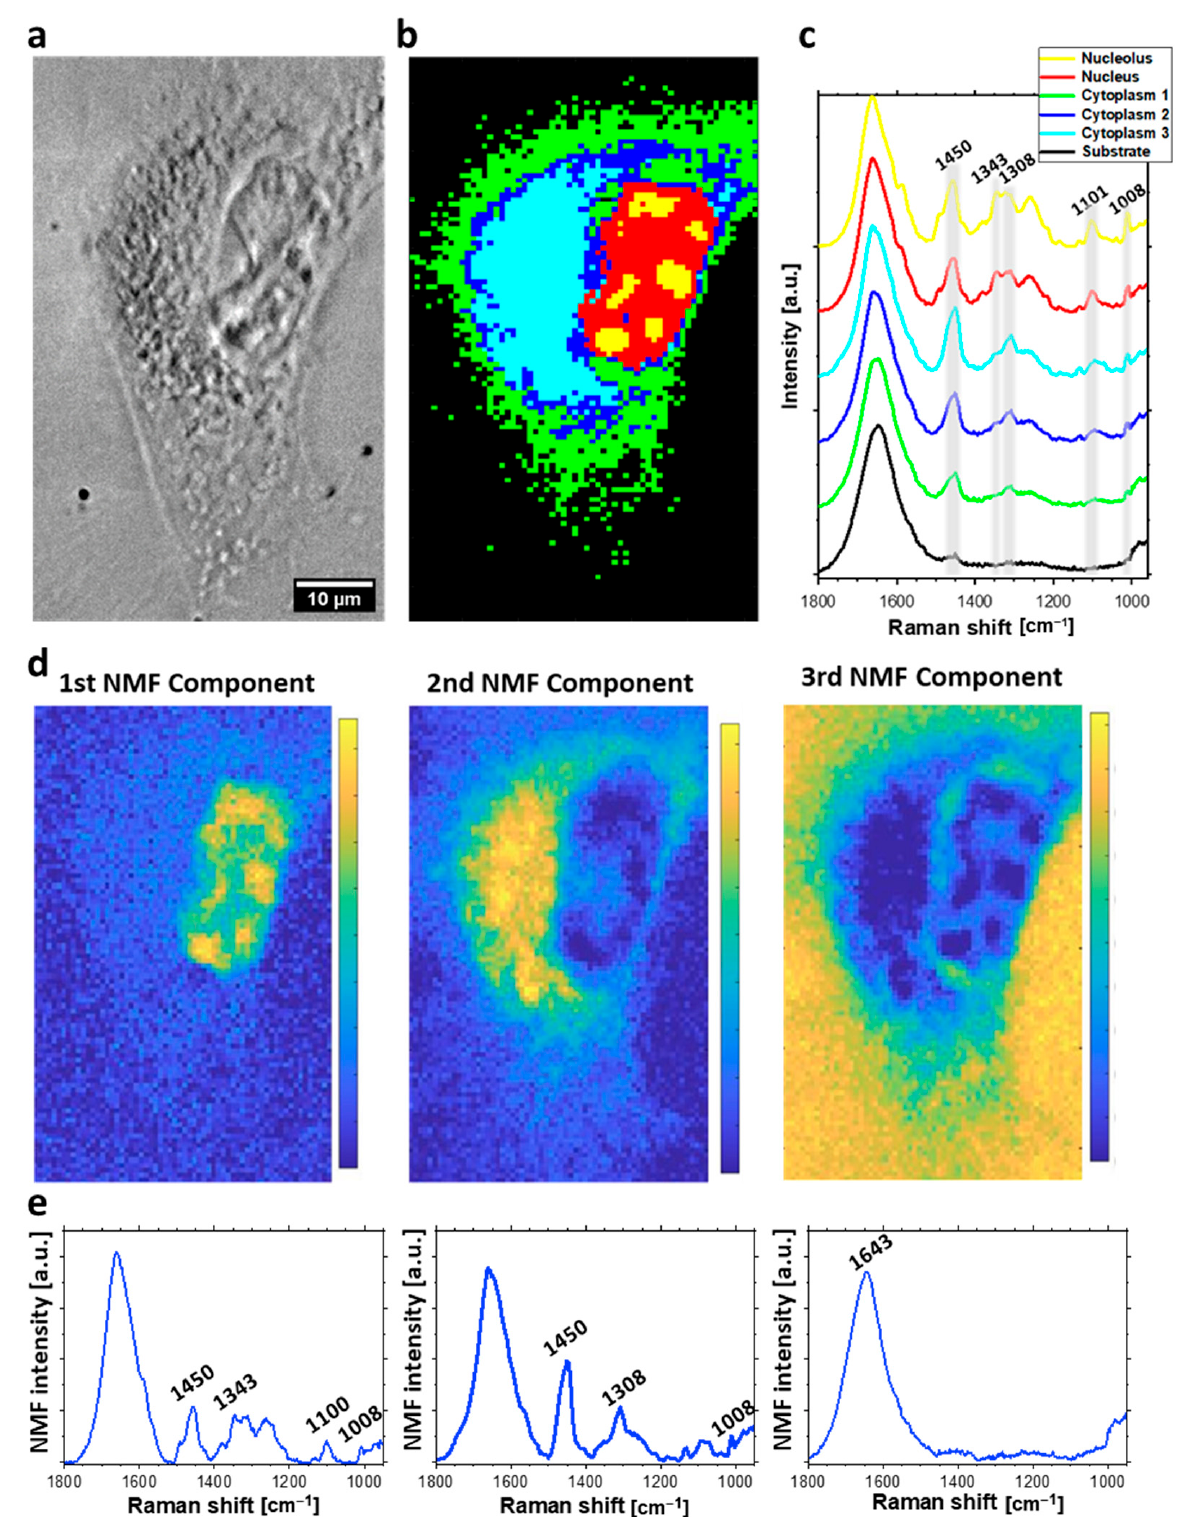
Figure 3. Raman imaging of HeLa cell incubated with 150 µM for 24 h: ( a ) optical image; ( b ) HCA map; ( c ) HCA mean Raman spectra (color of each spectrum corresponds to color of the cluster in ( b )); ( d ) distribution of NMF components; ( e ) corresponding plots of NMF components.